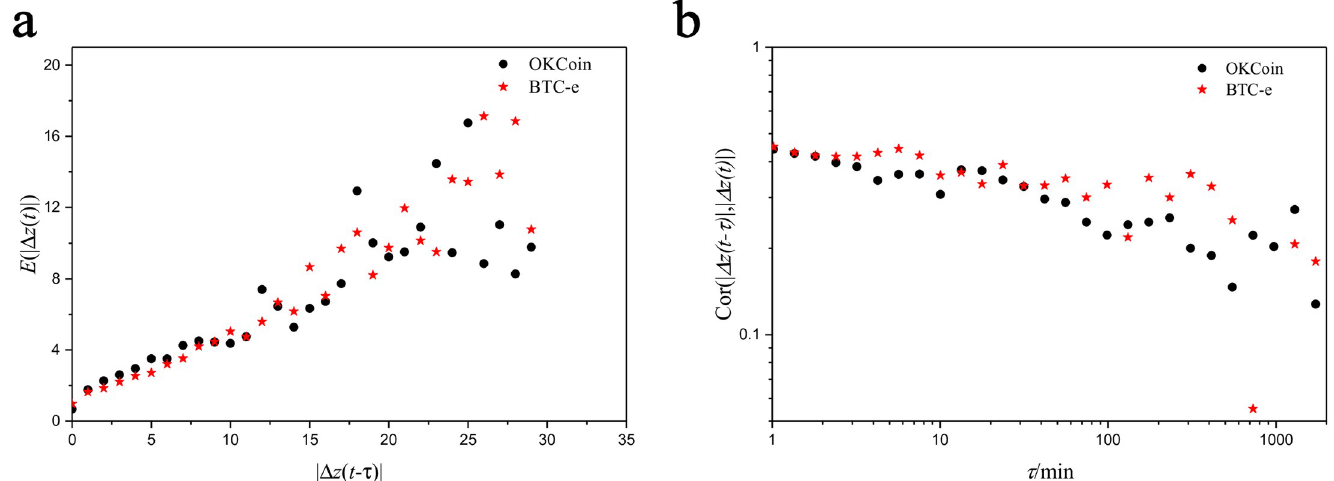
Fig 1. The predictability of the fluctuation in price in Bitcoin transaction platform. a . The relationship between the fluctuation of price in time t − τ and the fluctuation in time t . b . The autocorrelation of the price fluctuation Cor (| Δ z ( t − τ )|, | Δ z ( t )|) versus time interval τ .